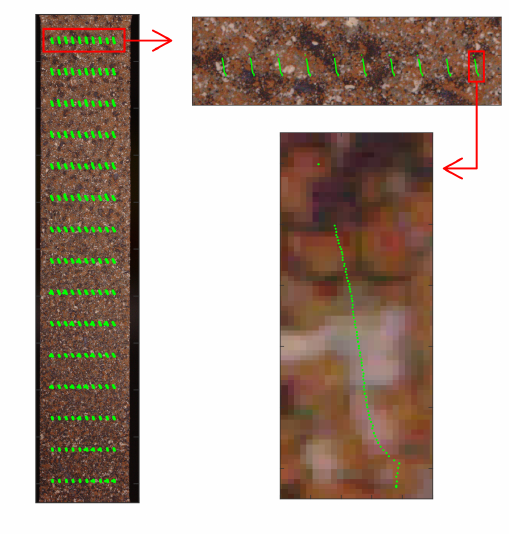
Figure 4. Detail of the displacement of a point during